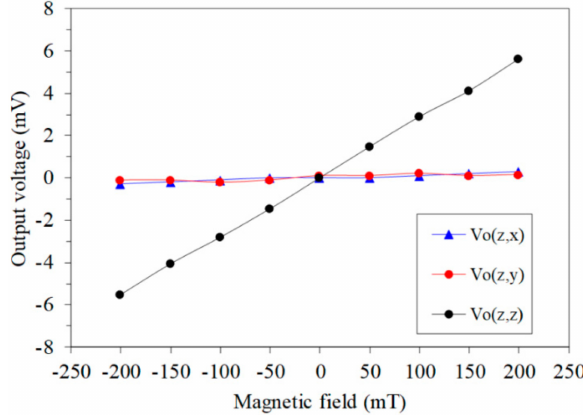
Figure 13. Output of the MMS in the z -axis magnetic field.